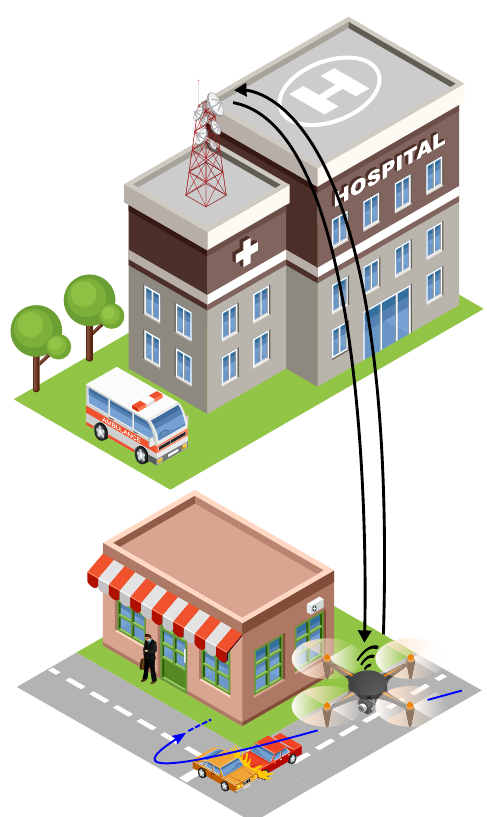
Figure 3. Interaction between a fully-autonomous drone and a ground control station in the case of an accident. The figure is extracted from Emine Laarouchi. An approach of safety analysis of CPS-IoT . PhD on-going work. Supervisors: Daniela Cancila and Hakima